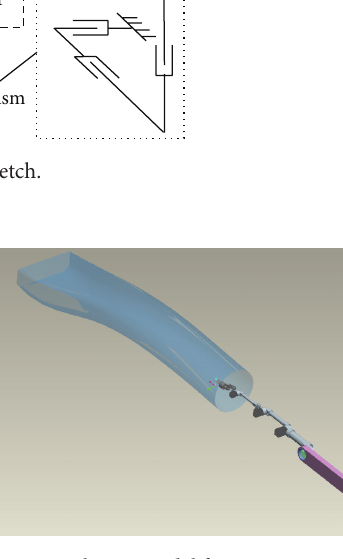
and the paint agitator were set as 0.25 MPa and 0.30 MPa, respectively. The paint flux of the spray gun was 0.17 L/min and the viscosity of the paint was 14.5 s. The operational parameters were set as 23.1 cm of the painting width, 7.1 cm of interlacing distance, 6.0 cm of overlapping distance, 16 cm of the gun standoff, and 12.5 cm/s of the sweeping speed in plane